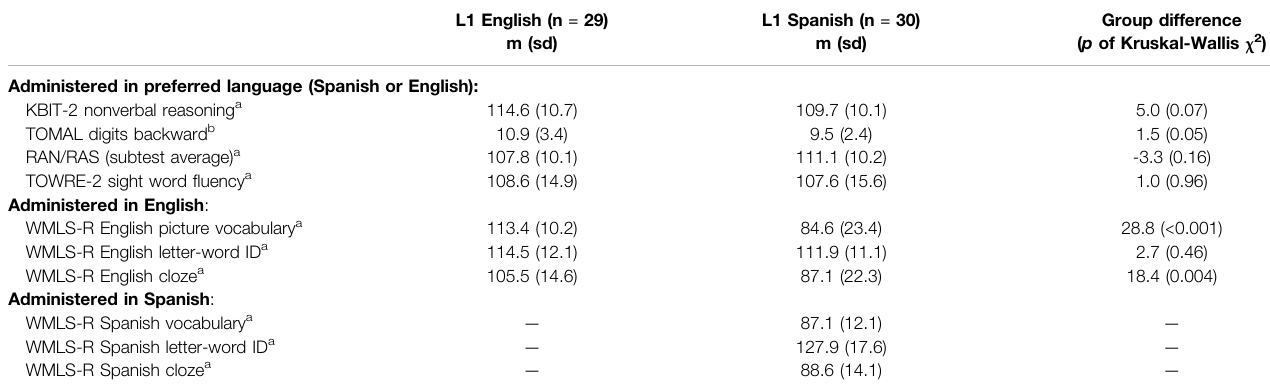
TABLE 2 | Reading and cognitive